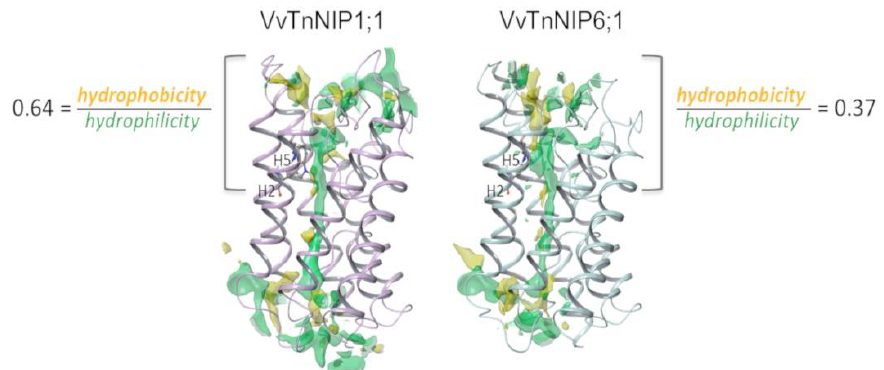
Figure 5. Hydrophobic ( yellow ) and hydrophilic ( green ) regions of the channel in VvTnNIP1;1 and VvTnNIP6;1.